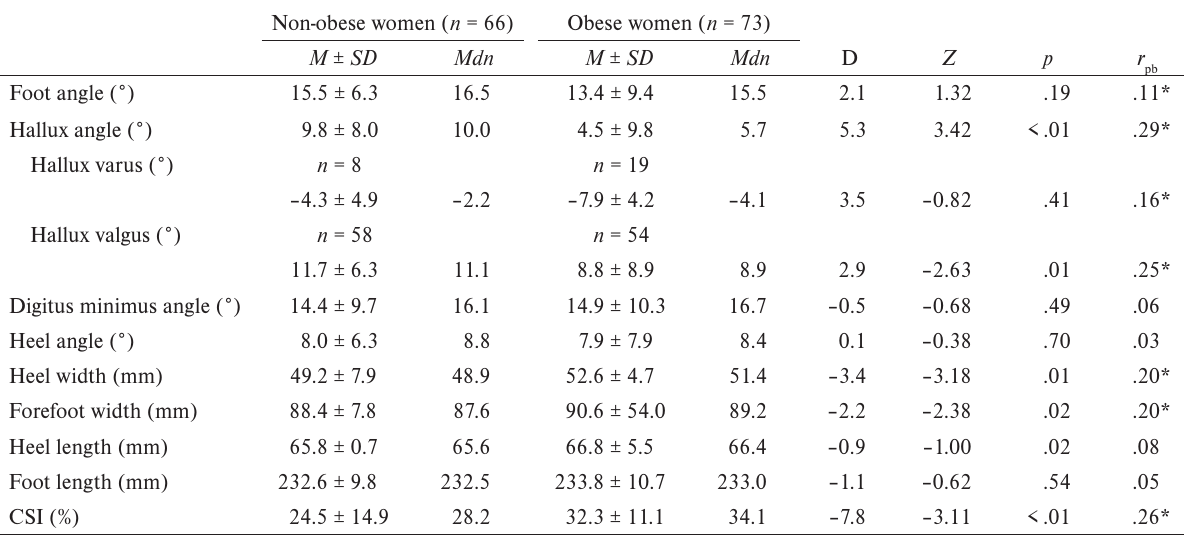
Comparison of the left foot parameters between non-obese and obese women Non-obese women ( n = 66)